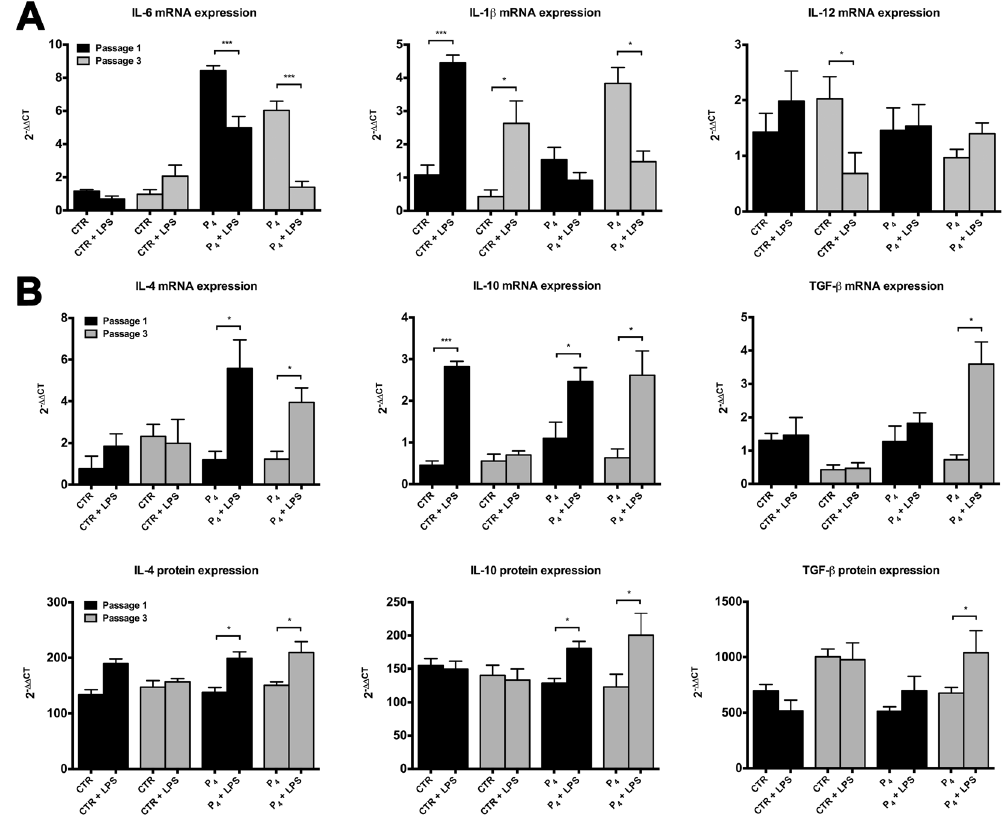
Figure 6. Effects of P 4 on pro- and anti-inflammatory cytokines expression and release. ( A ) Comparison between basal and 24 h LPS-induced IL-1 β , IL-6 and IL-12 mRNA expression in CTR and P 4 -treated oAEC, at passage 1 (black bars) and 3 (grey bars). ( B ) Comparison between basal and 24 h LPS-induced IL-10, IL-4 and TGF- β mRNA expression and protein release in CTR and P 4 -treated oAEC, at passage 1 (black bars) and 3 (grey bars). The ΔΔ Ct values of LPS-stimulated samples are calculated by normalizing against the Δ Ct values obtained from CTR and P 4 -treated samples without LPS, respectively. * p < 0.05 and *** p < 0.001. Abbreviation: CTR, control cell; P 4 , progesterone; LPS,